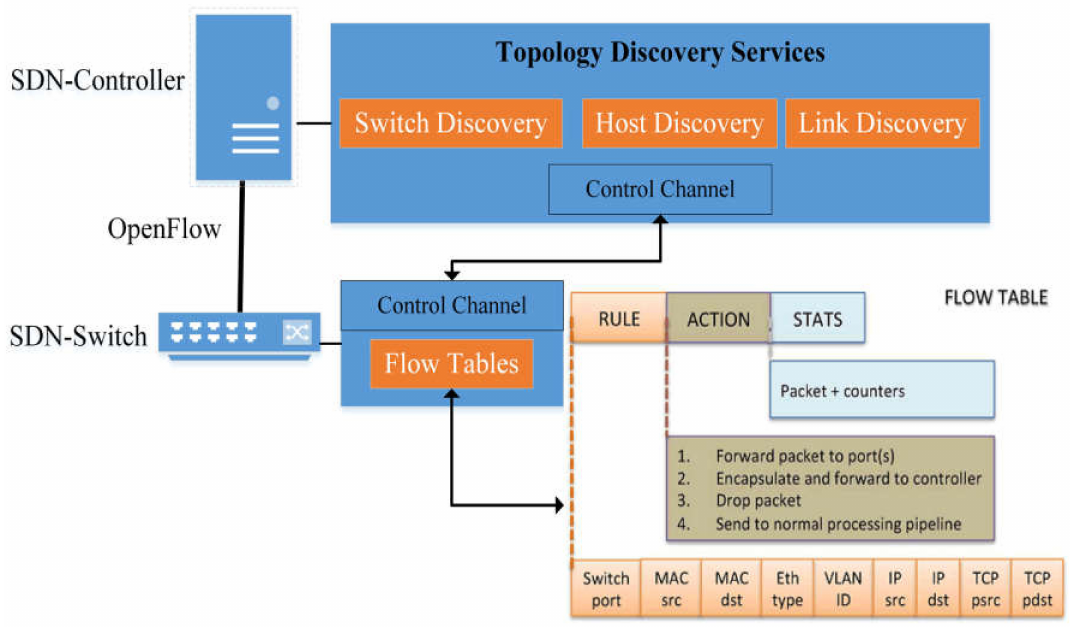
Figure 2. Topology discovery processes